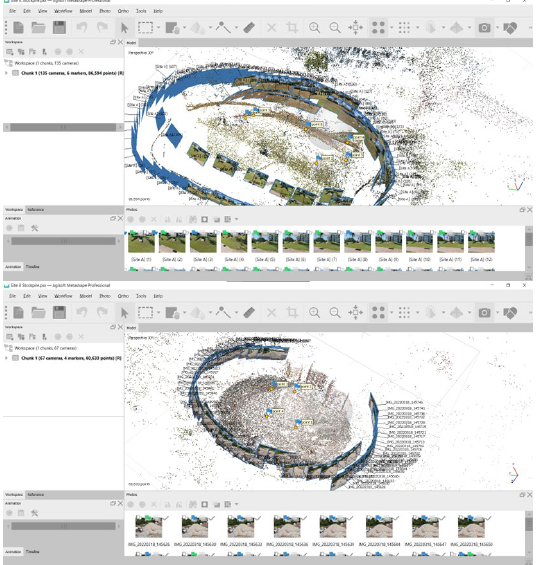
Figure 3.5. Point Cloud Generation by Agisoft